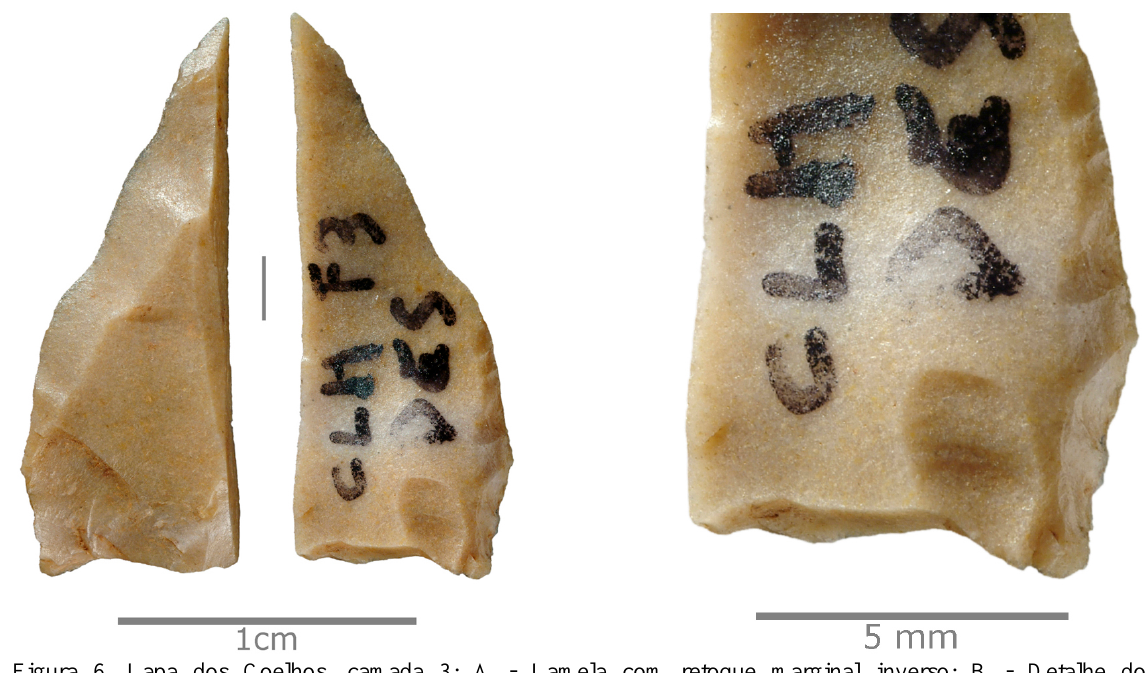
Figura 6. Lapa dos Coelhos, camada 3: A - Lamela com retoque marginal inverso; B - Detalhe do esquirolamento do bolbo (Fotos de J. P. Ruas). Figure 6. Lapa dos Coelhos, camada 3: A - Marginal, inverse retouch bladelet; B - Detail showing splintering of the butt (Photos by J. P.